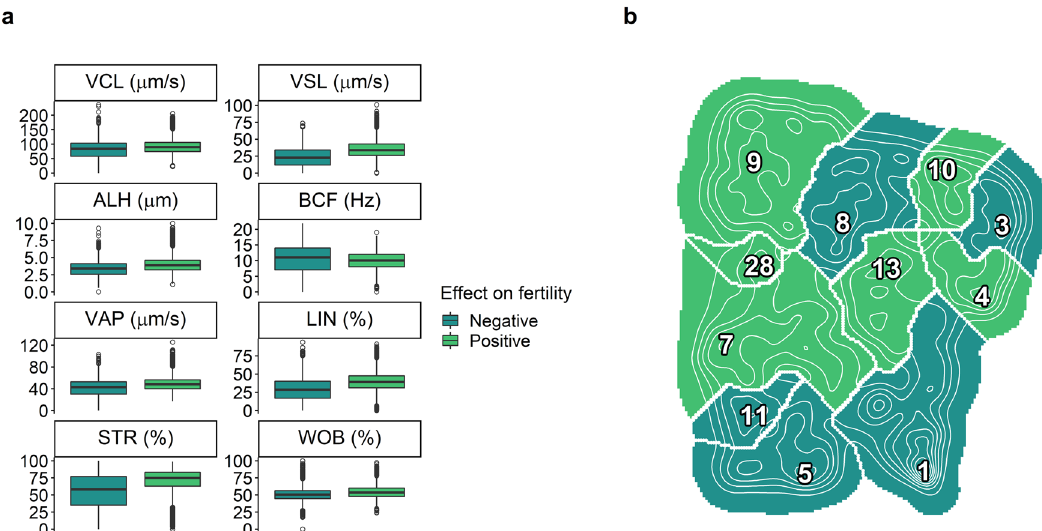
Fig. 3 Impact of sperm motility features on fertility. a Boxplots of the motility features (VCL, curvilinear velocity; VSL, straight-line velocity; ALH lateral amplitude of head displacement; BCF, beat-cross frequency; VAP, average path velocity; LIN, linearity; STR, straightness; and WOB, wobble) grouped by their effect (either positive or negative) on fertility, according to model M3. Mean values (positive-negative) for each motility variable: ALH (3.94 − 3.26 μ m), VAP (48.72 − 40.29 μ m/s), STR (71.61 − 54.26%), LIN (39.60 − 28.49%), VSL (34.94 − 23.64 μ m/s), BCF (10.03 − 10.14Hz), WOB (54.50 − 48.52%) and VCL (90.80 − 79.19 μ m/s). Mean comparisons between the two groups (two-sided unpaired T-student tests; number of samples per group: positive = 36482, negative = 32688) yielded a p value<10 − 15 in all motility variables, except for BCF ( p value<10 − 3 ). Both groups met the assumptions of T-student test in all variables tested. b 11-cluster motility landscape showing the clusters with positive (light green) and negative (dark green) correlation with fertility, according to model M3. The high-density peaks (labelled with the cluster number) are also depicted, as well as contour lines to help visualise the stereotypes (as in Fig. 1).